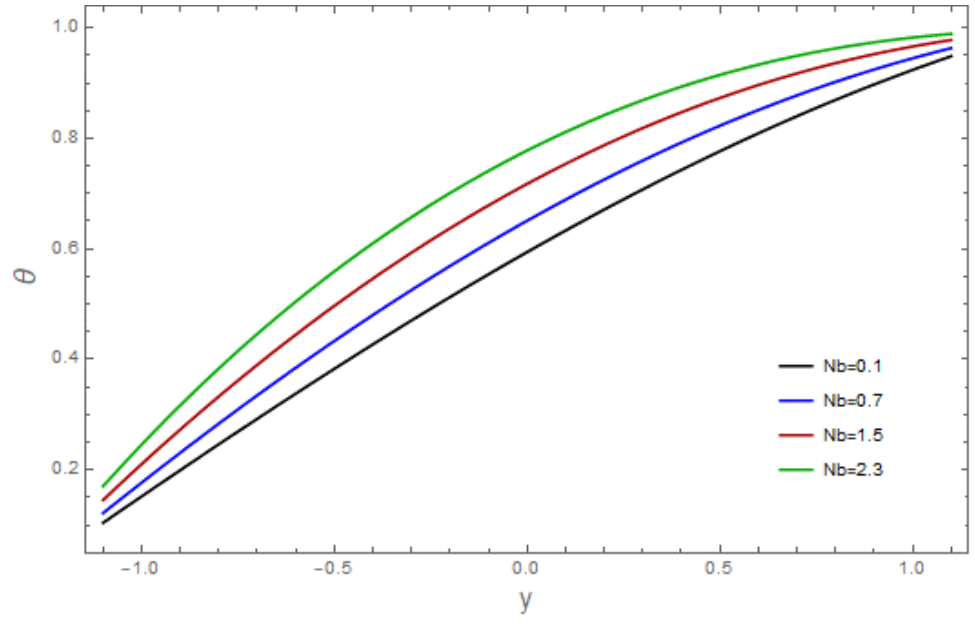
Figure 11. Effect of 𝑁𝑏 on 𝜃 .